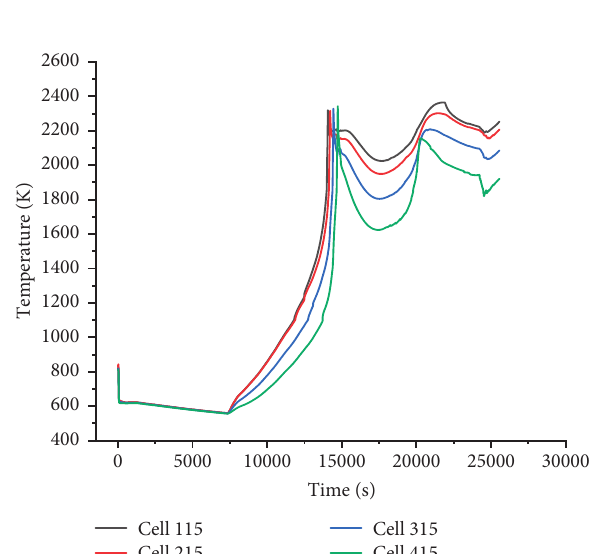
Figure 4: The node temperature in the outer layer.